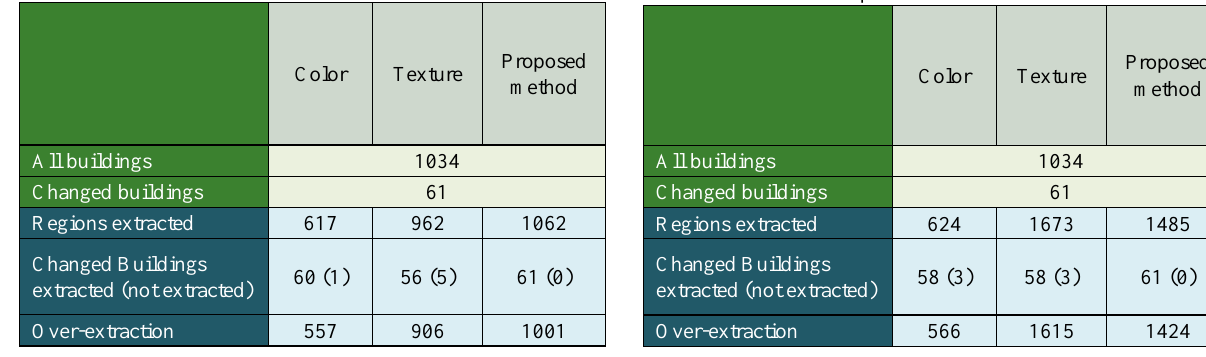
Table 6. Comparison results between the proposed method